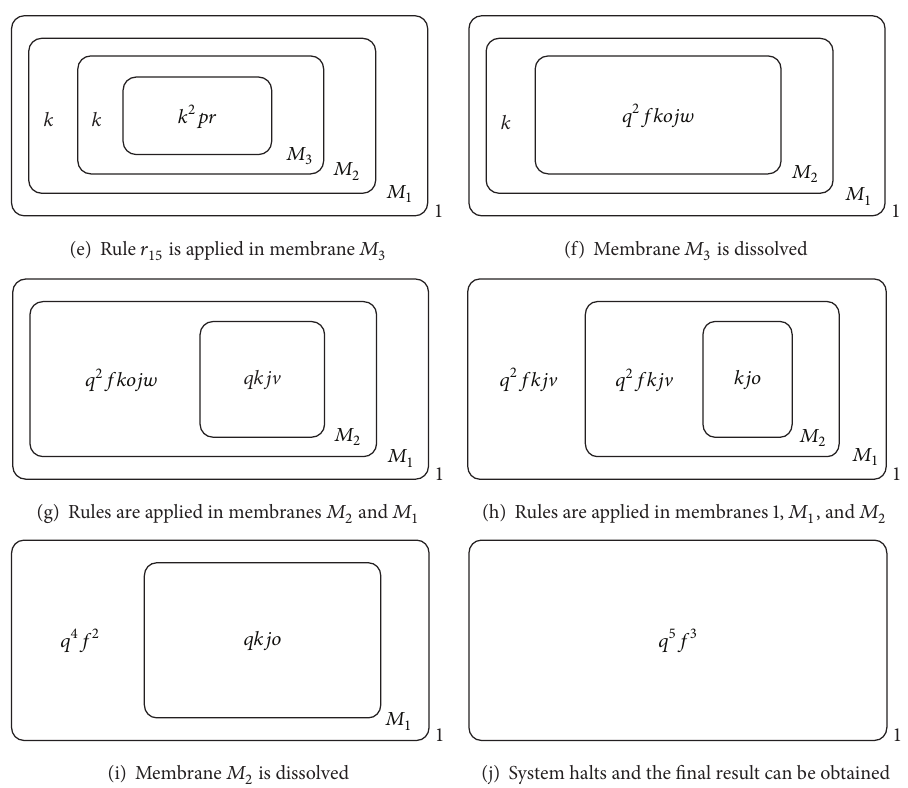
Figure 4: The procedure of reducing 6/10 in the designed P